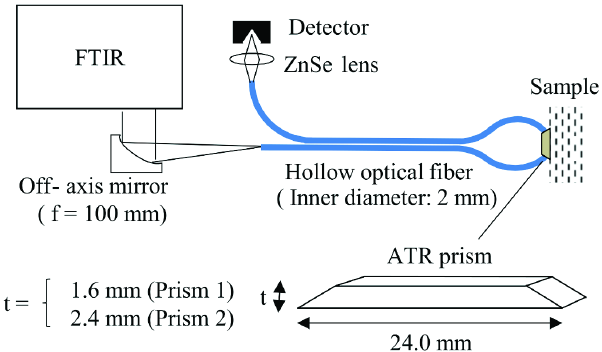
Fig. 1. Experimental setup and dimensions of ATR